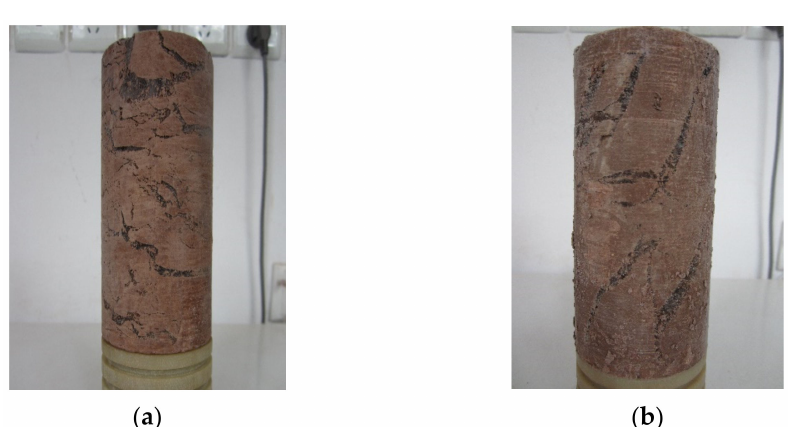
Figure 3. Standard undisturbed samples: ( a ) water content: 22.08%, ( b ) water content: